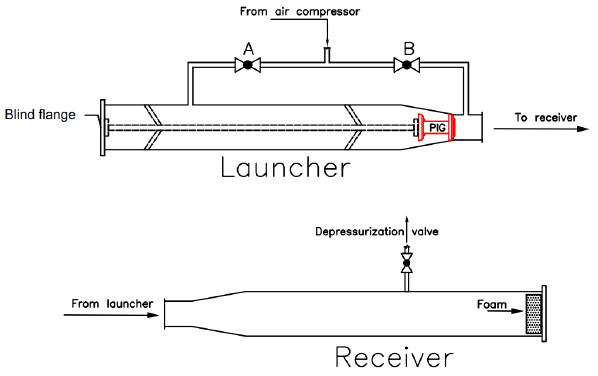
Figure 32. Representation of the PIG launcher and receiver.